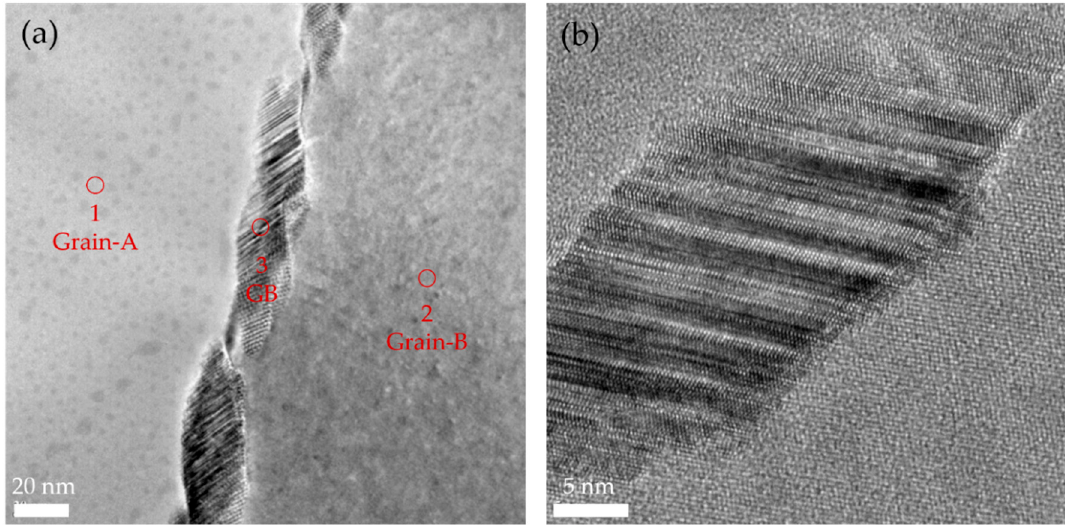
Figure 5. ( a ) Bright field transmission electron microscopy (TEM) image of a GB with precipitates. ( b ) High resolution TEM image of SiC precipitate at the GB. Energy dispersive X-ray spectroscopy (EDS) analysis was performed at GB and neighbored grains. Table 1. EDS element analysis.